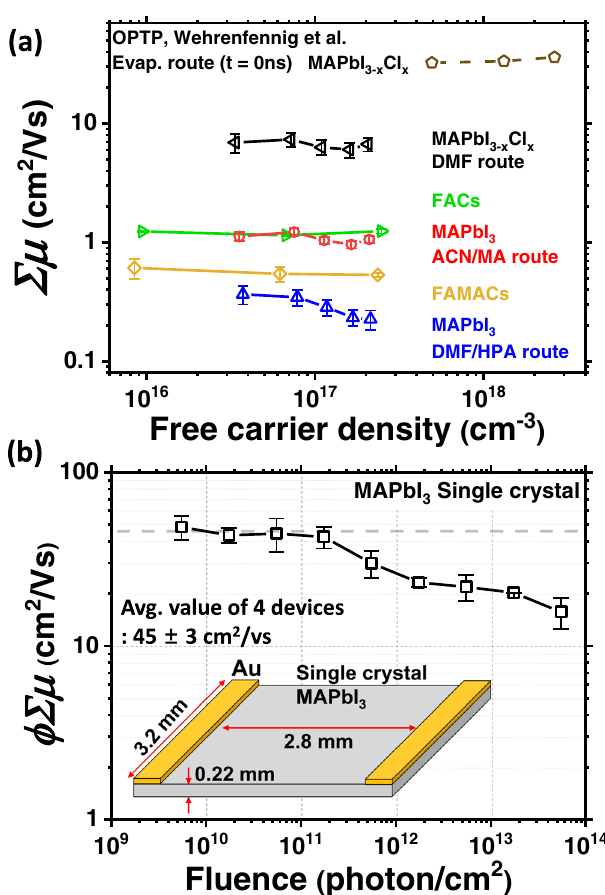
Fig. 4 Evaluation of carrier density invariant lateral mobility of metal halide perovskite. a Mobility of metal halide perovskite thin- fi lms prepared via different methodologies as a function of free-carrier density (cm − 3 ); CH 3 NH 3 PbI 3-x Cl x from dimethyl formamide solvent (DMF route, black line), CH 3 NH 3 PbI 3 from the acetonitrile solvent with the addition of methylamine (ACN/MA route, red line), CH 3 NH 3 PbI 3 from DMF as the solvent employing lead-acetate as the lead source precursor with the addition of hypophosphorous acid (HPA) (DMF/HPA route, blue line), FA 0.83 Cs 0.17 Pb(I 0.9 Br 0.1 ) 3 (FACs, green line) and (FA 0.83 MA 0.17 ) 0.95 Cs 0.05 Pb(I 0.9 Br 0.1 ) 3 (FAMACs, yellow line). For comparison, we reproduce mobilities of CH 3 NH 3 PbI 3- x Cl x (evaporation route) determined through non-contact OPTP (brown dashed line). b Mobility of CH 3 NH 3 PbI 3 (MAPbI 3 ) thin single crystals as a function of fl uence (photon cm − 2 ). Average mobility of three devices is 45±3cm 2 V − 1 s − 1 (grey dashed line). The inset illustration shows device structure. All errors shown are statistical errors from four different